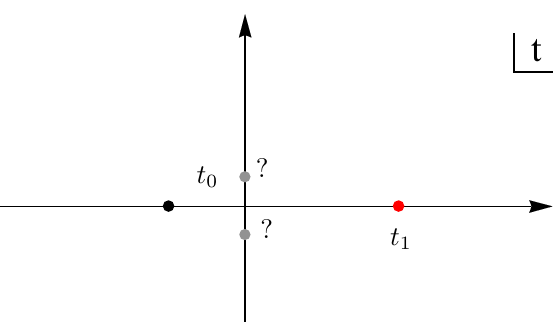
Figure 2 . Possible conjectured position of the singularities closest to the origin (black, red and grey dots) of the Borel transform of the MS (cid:12) -function. The red singularity might be due to an IR renormalon or to an instanton anti-instanton con(cid:12)guration, the black one to a UV renormalon, the grey ones of unknown